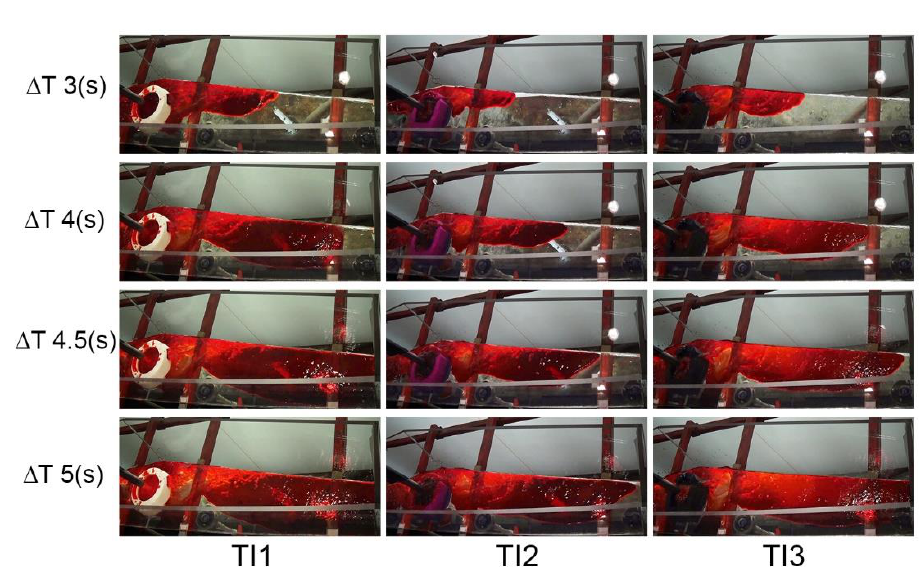
Figure 3. Streams of liquid water streams at startup operation using different tundish